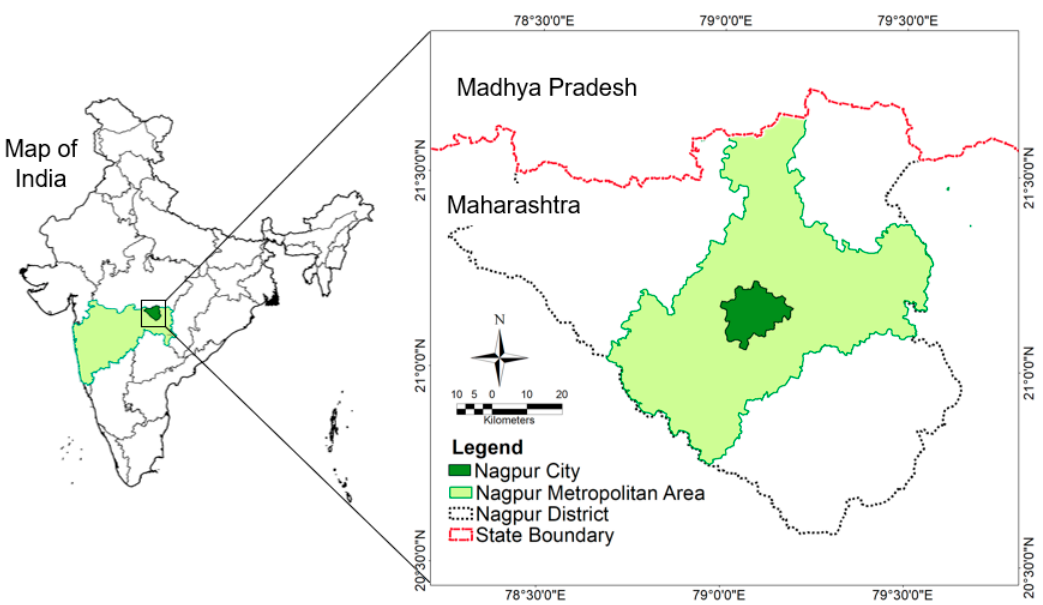
Figure 1. Location map of Nagpur City and Nagpur Metropolitan Area in India (source: the